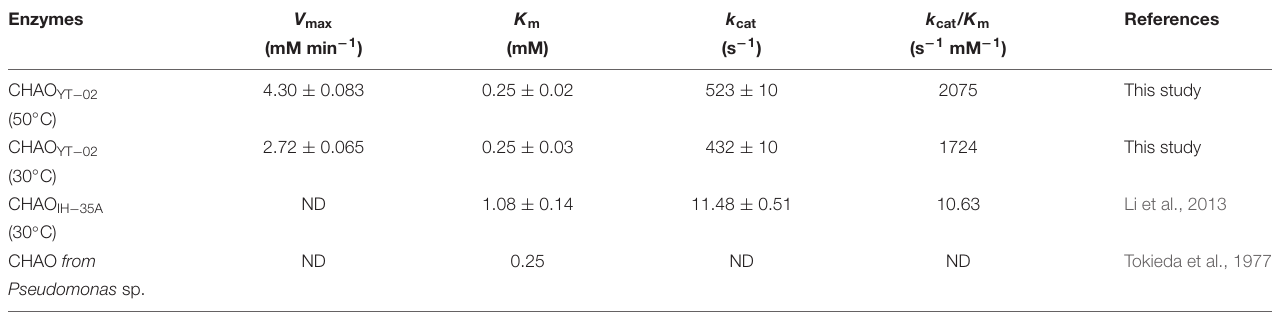
TABLE 3 | Kinetic parameters of CHAOs toward